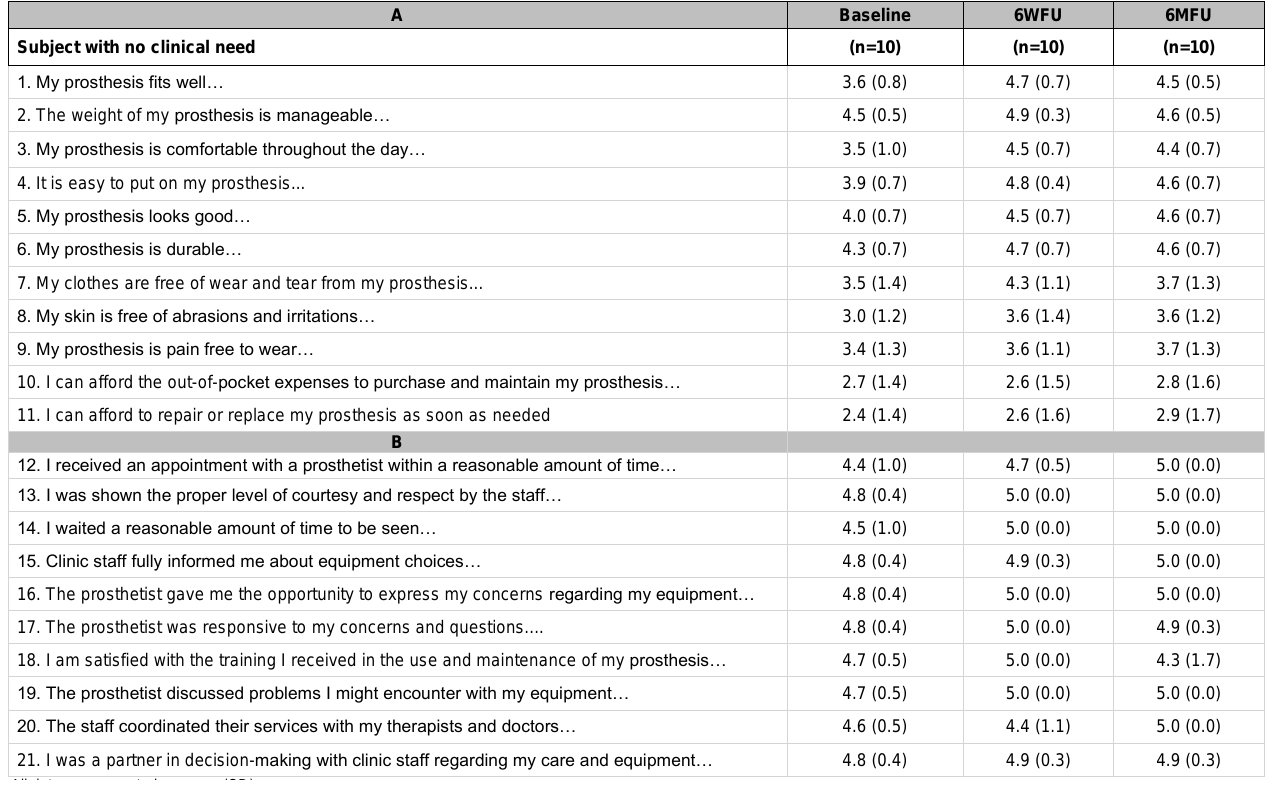
Table 5: A: OPUS Client Satisfaction Device (CSD) (questions 1-11); B: OPUS Client Satisfaction with Services (CSS) (questions